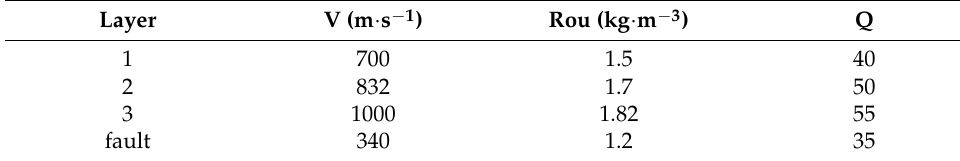
Figure 9. Display of numerical simulation. ( a ) is a map view of the two-dimensional normal fault model. ( b ) is the histogram of dominant frequency distribution of source. ( c – f ) are wave field snapshots at different times. Table 2. Parameters of two-dimensional normal fault model.